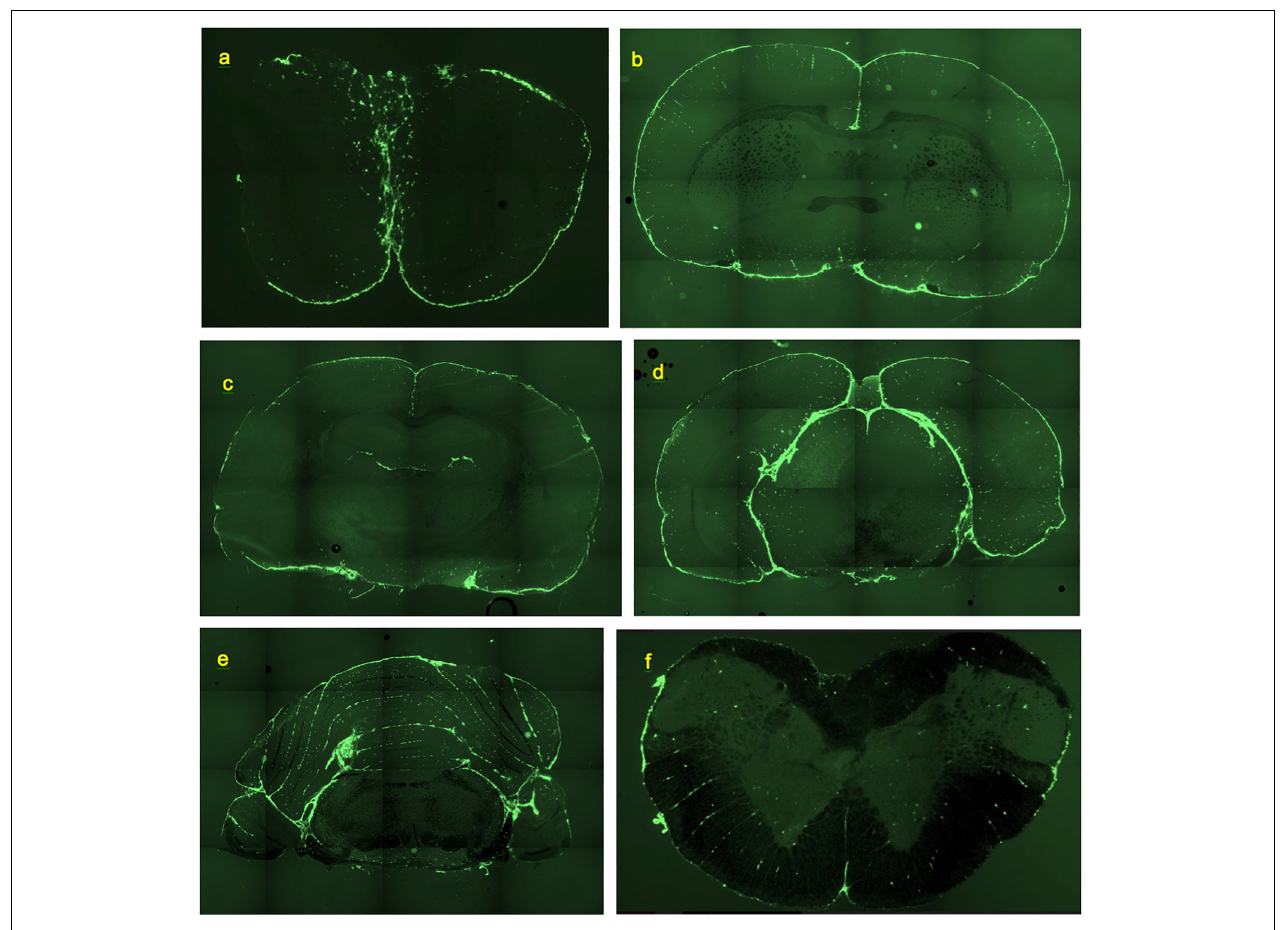
FIGURE 1 | Deposition of FITC-rhNAGLU in the CNS of rat, 24 h after administration to cisternal CSF. Unstained, unfixed coronal 20 µ m cryosections. (a) Olfactory bulbs. (b) Brain section at the level of rostral anterior commissure. (c) Brain section through hippocampal formation and thalamus. (d) Brain section through pineal gland. (e) Cerebellum and brainstem section ca. 0.5 mm rostral of the facial nerves. (f) Section through cervical spinal cord. See “Materials and Methods” for section reference to Paxinos atlas (Paxinos and Watson, 2013). Field of view: (a) : 8.8 mm × 5.9 mm, (b–e) : 17.7 mm × 11.8 mm, (f) : 4.4 mm × 2.9 mm. High resolution versions: Supplemental Figures S9–S14